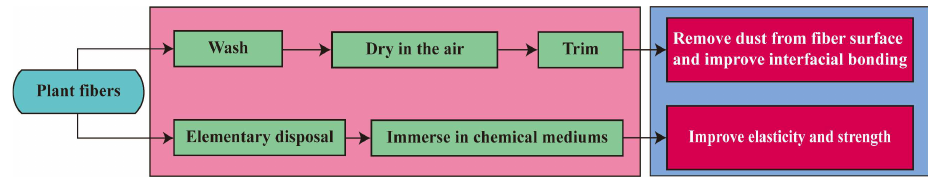
Figure 10. The general process of surface treatment of plant fibers.